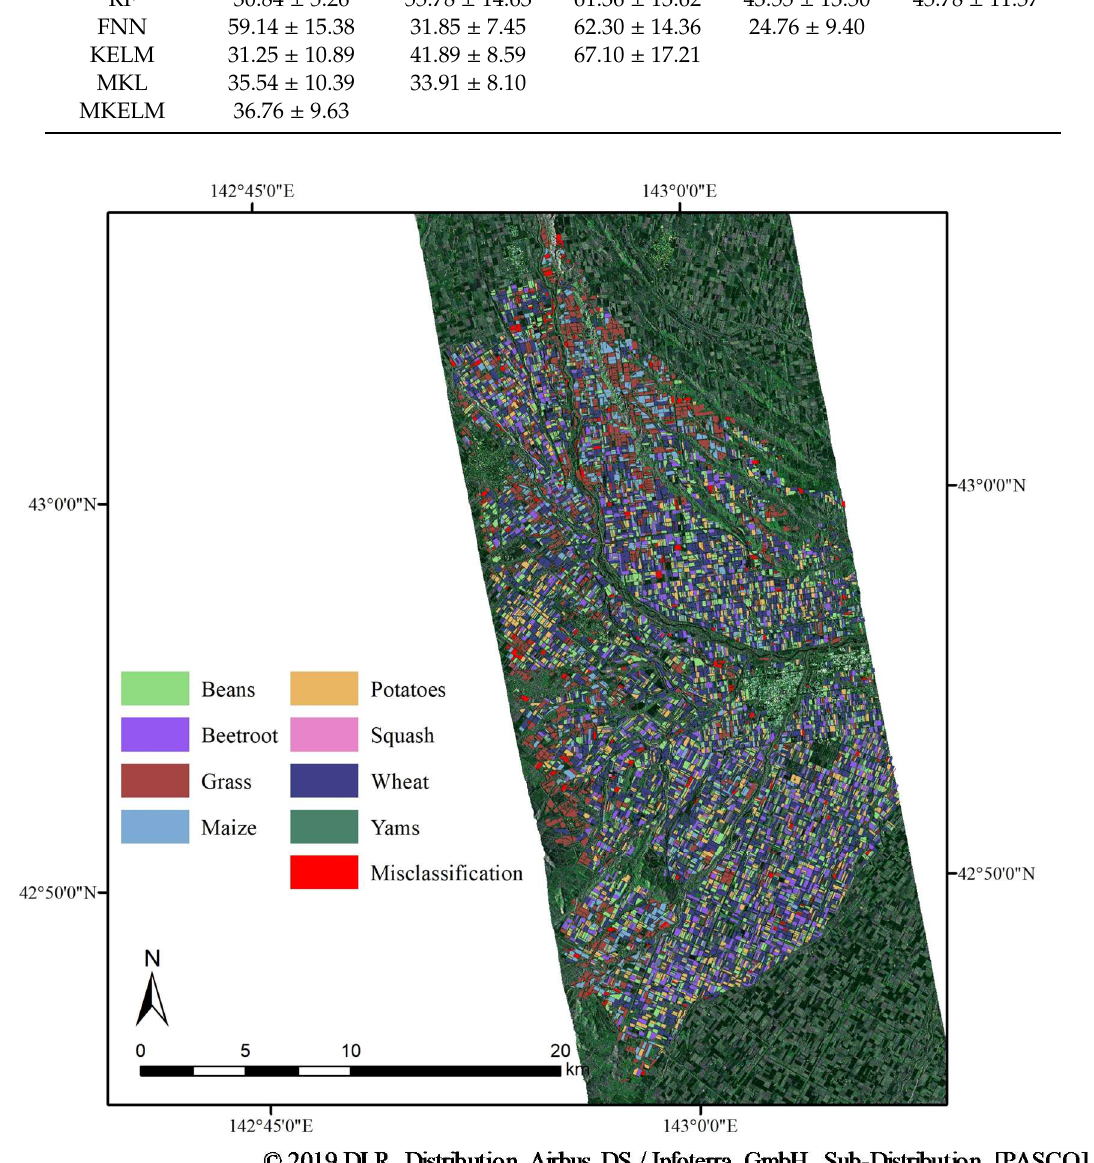
Figure 3. Crop classification map based on MKL. Red-colored fields were misclassified.